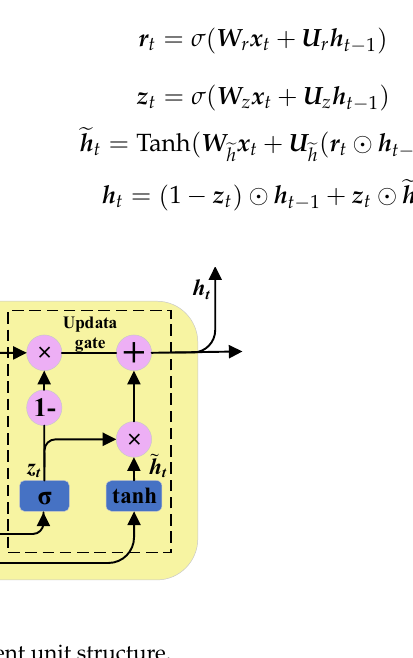
Figure 8. TCN residual block. k is the kernel size, and d is the dilation factor.